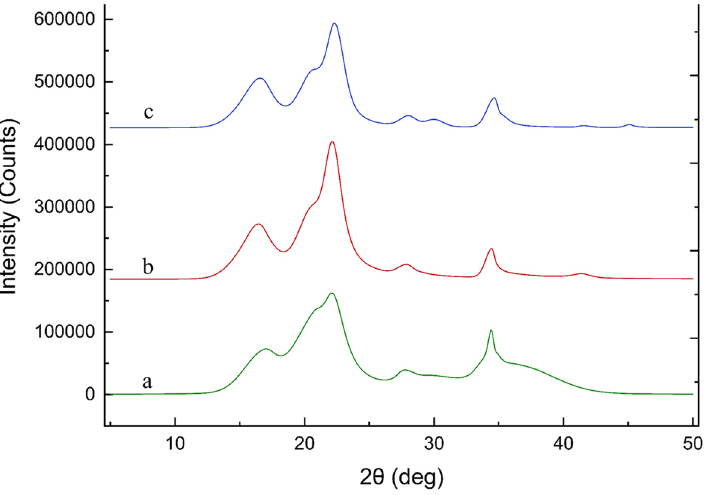
Figure 5. XRD analysis of the as-produced TEMPO-CNFs (a) and the as-produced TEMO-CNNFs after heated in 150 °C saturated water vapor for 4hours : sample (b) is with- and sample (c) is without-containing the yellowish substances. Thicknesses of the samples were about 120 μm by folding the 15 μm-thickness film samples 3